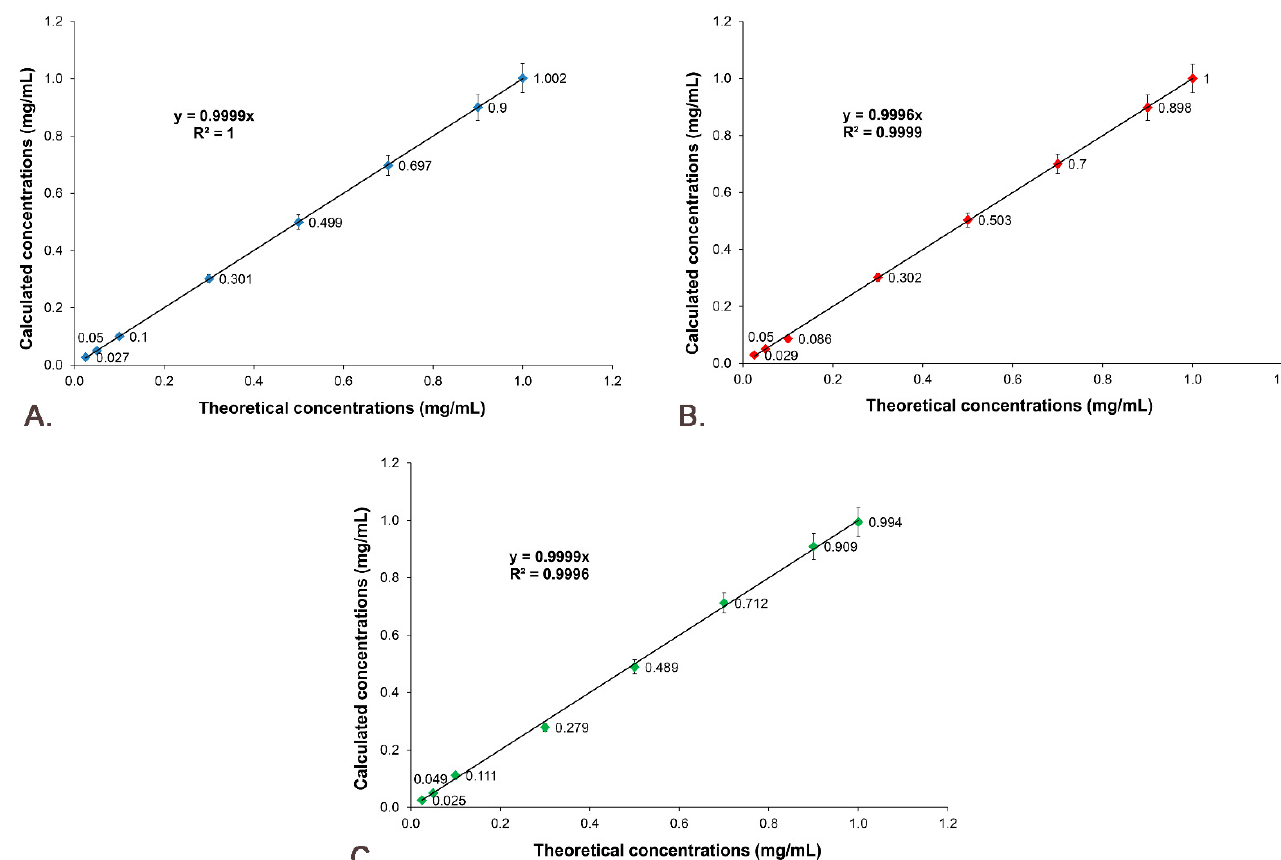
Figure 12. Linearity of the results: ( A ) Sil A; ( B ) Sil B; ( C ) Gli.